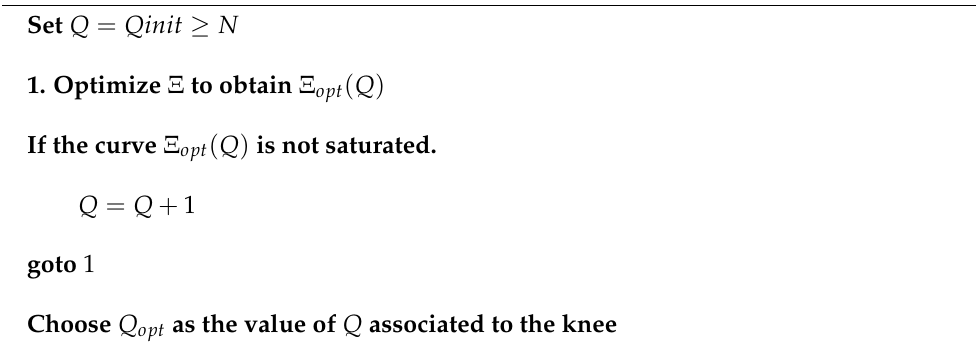
Algorithm 1 SVO algorithm: determining the number of